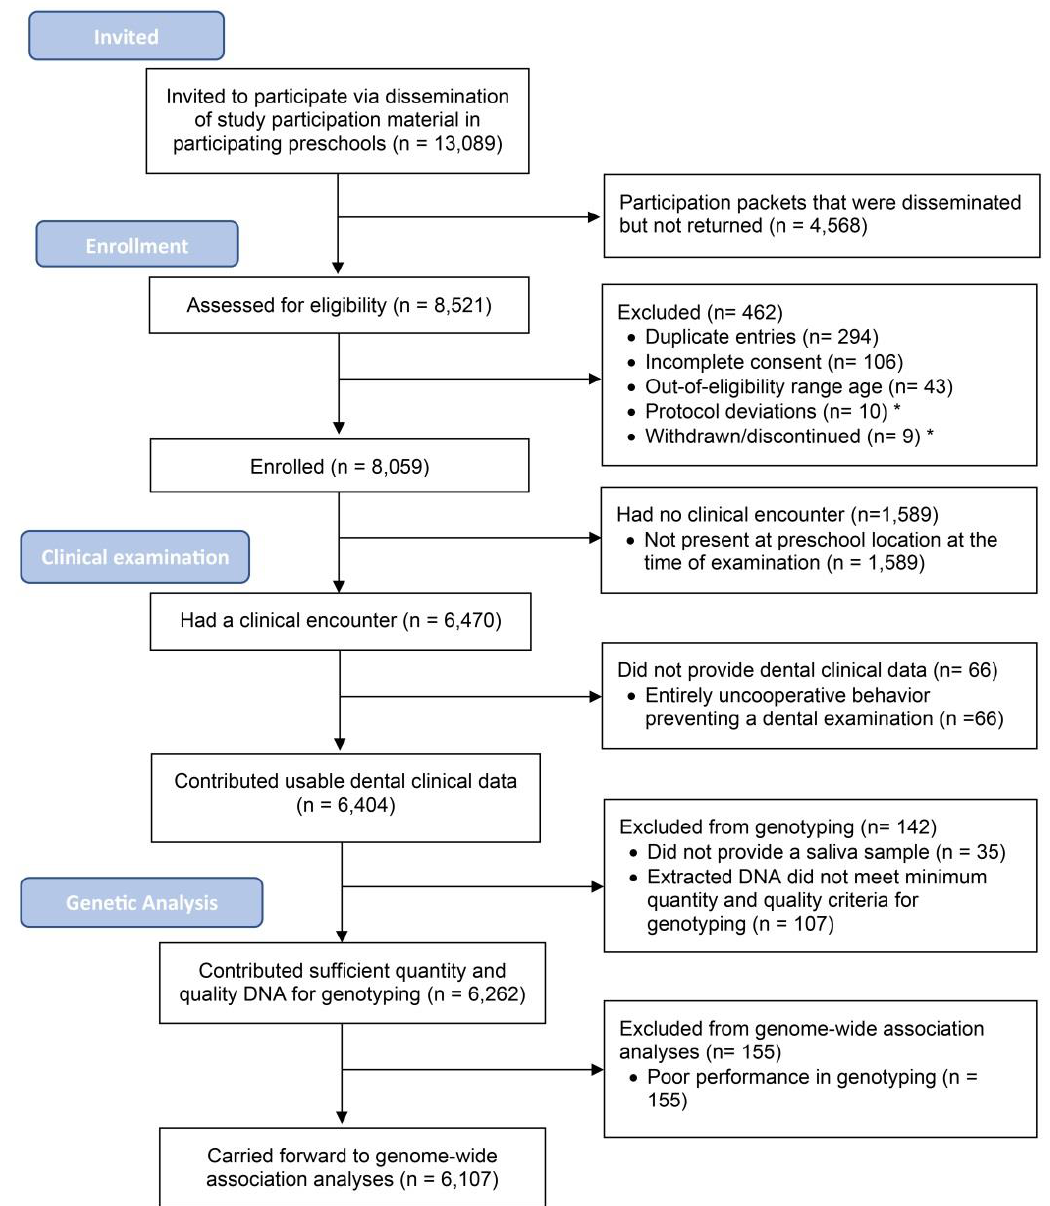
Figure 2. Flowchart of enrollment, clinical examinations, and derivation of the GWAS analytical samples in the ZOE 2.0 study, North Carolina, United States (the 19 participants that are identified with protocol deviations that were withdrawn, or discontinued were initially considered as part of enrollment, but were removed from the study enrollment and do not count towards the reported enrollment figure of